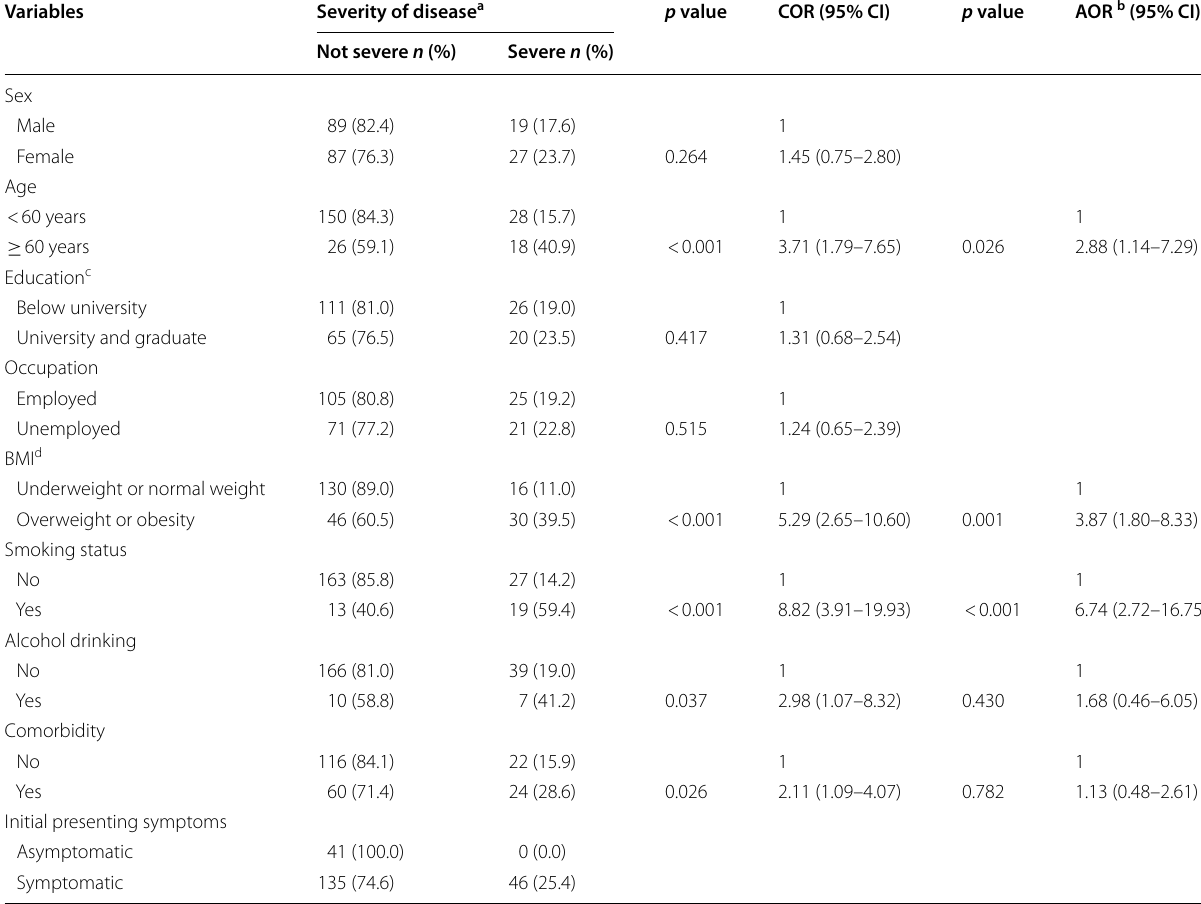
Table 4 Association of severity of disease with demographic characteristics, comorbidity and initial presenting symptoms in COVID- 19